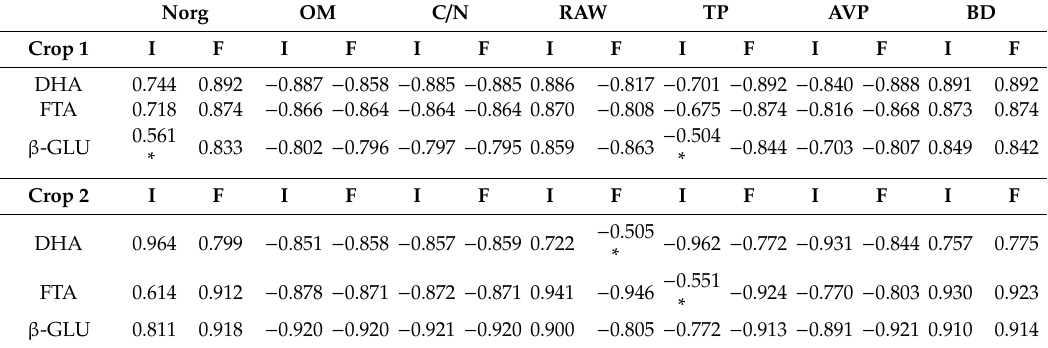
Table 7. Correlations between initial physicochemical (I) and final (F) properties of the substrates and enzymatic